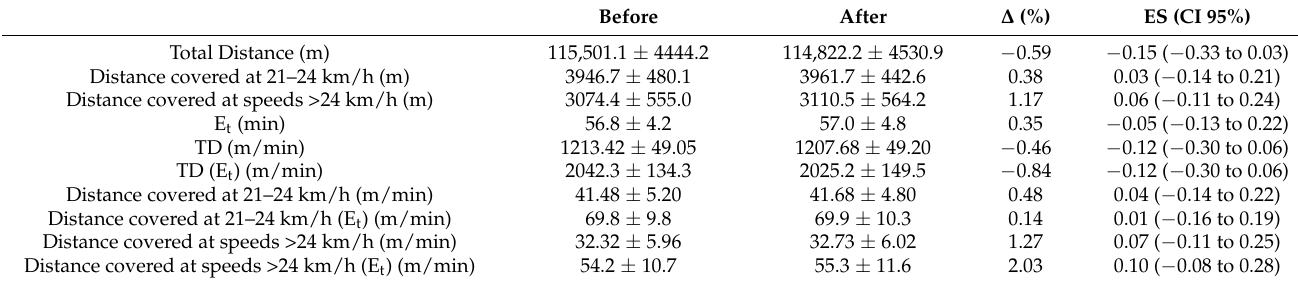
Table 1. Changes of physical and technical match performance in German League before and after the COVID-19 breakdown (mean and